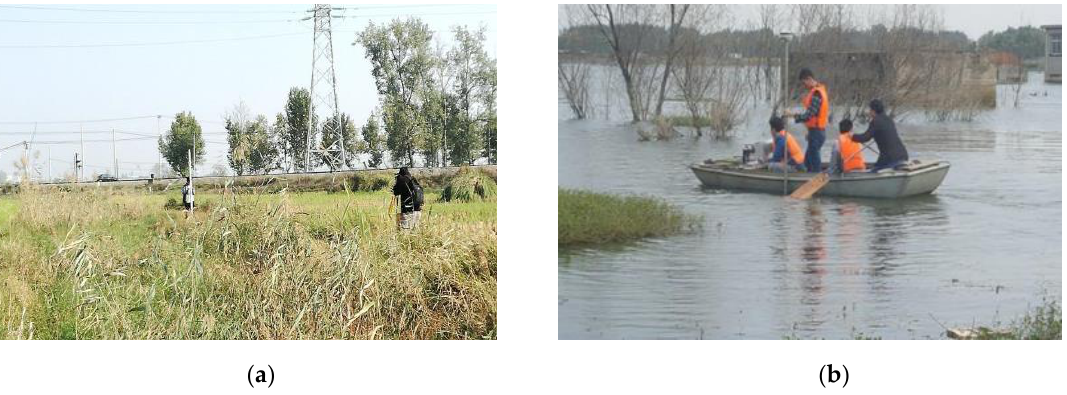
Figure 3. The measurement process of monitoring points. ( a ) Surface monitoring point measurement. ( b ) Underwater monitoring point measurement.